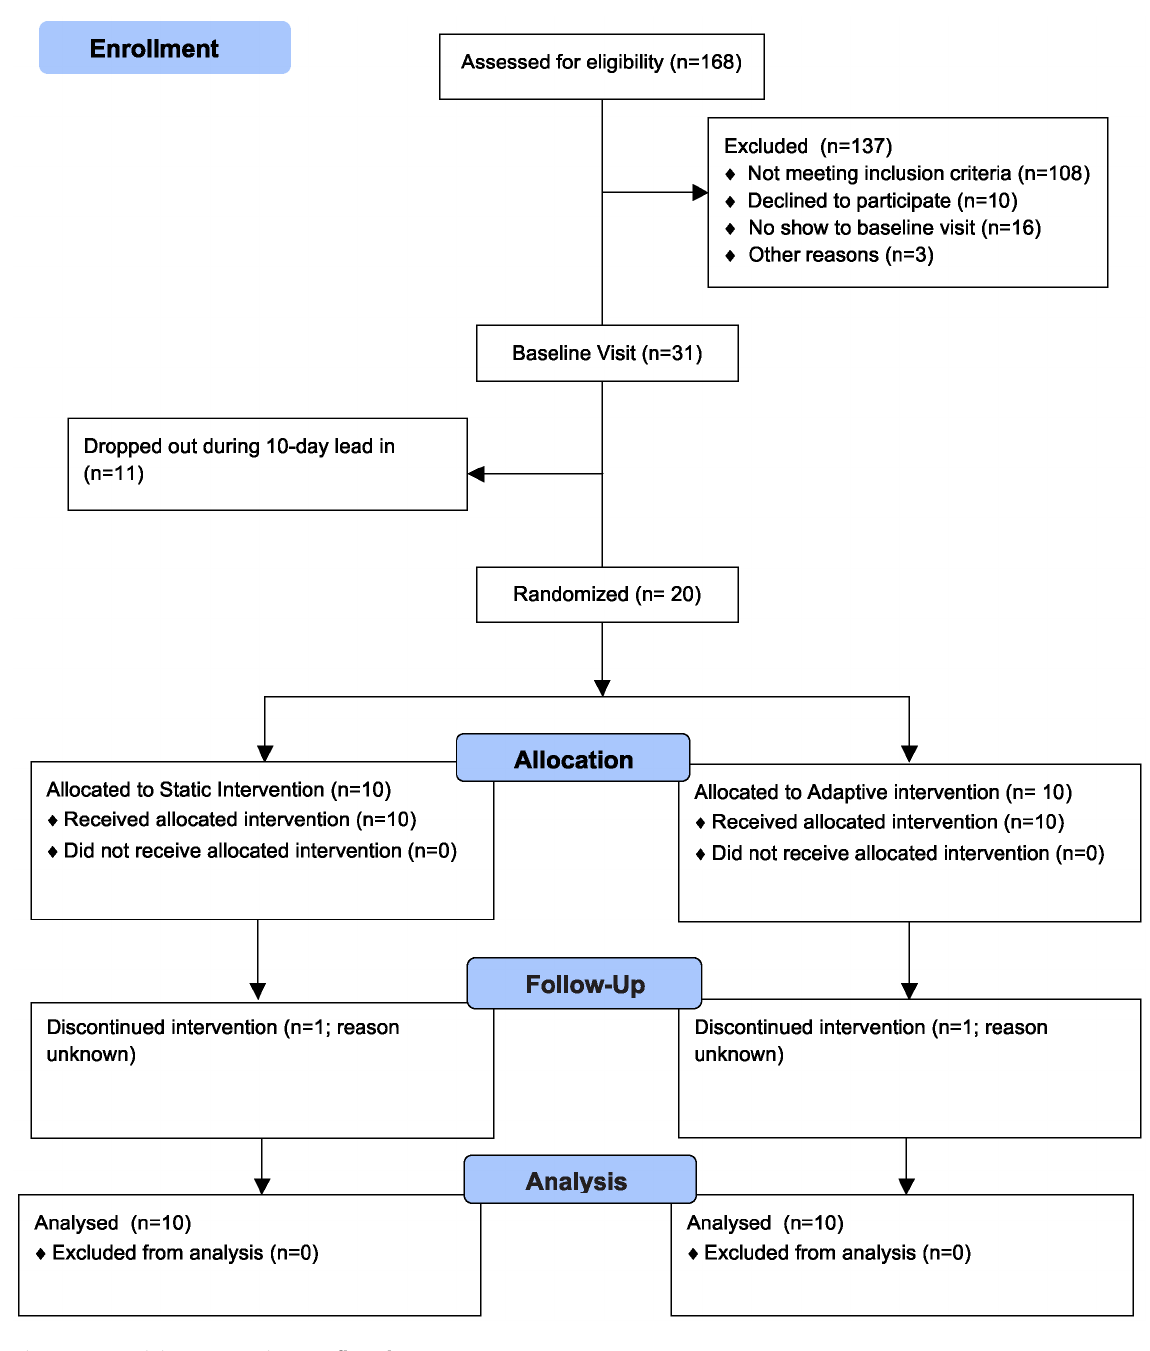
Figure 2. Participant recruitment flowchart.